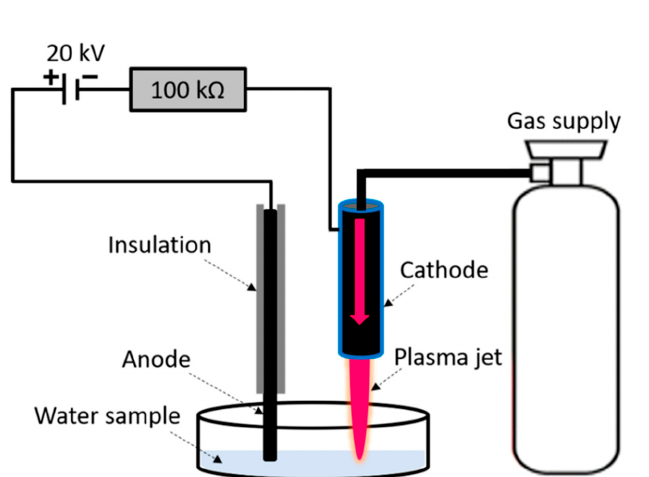
Figure 1. An argon plasma jet setup for production of nanoparticles by reduction the metal ions.